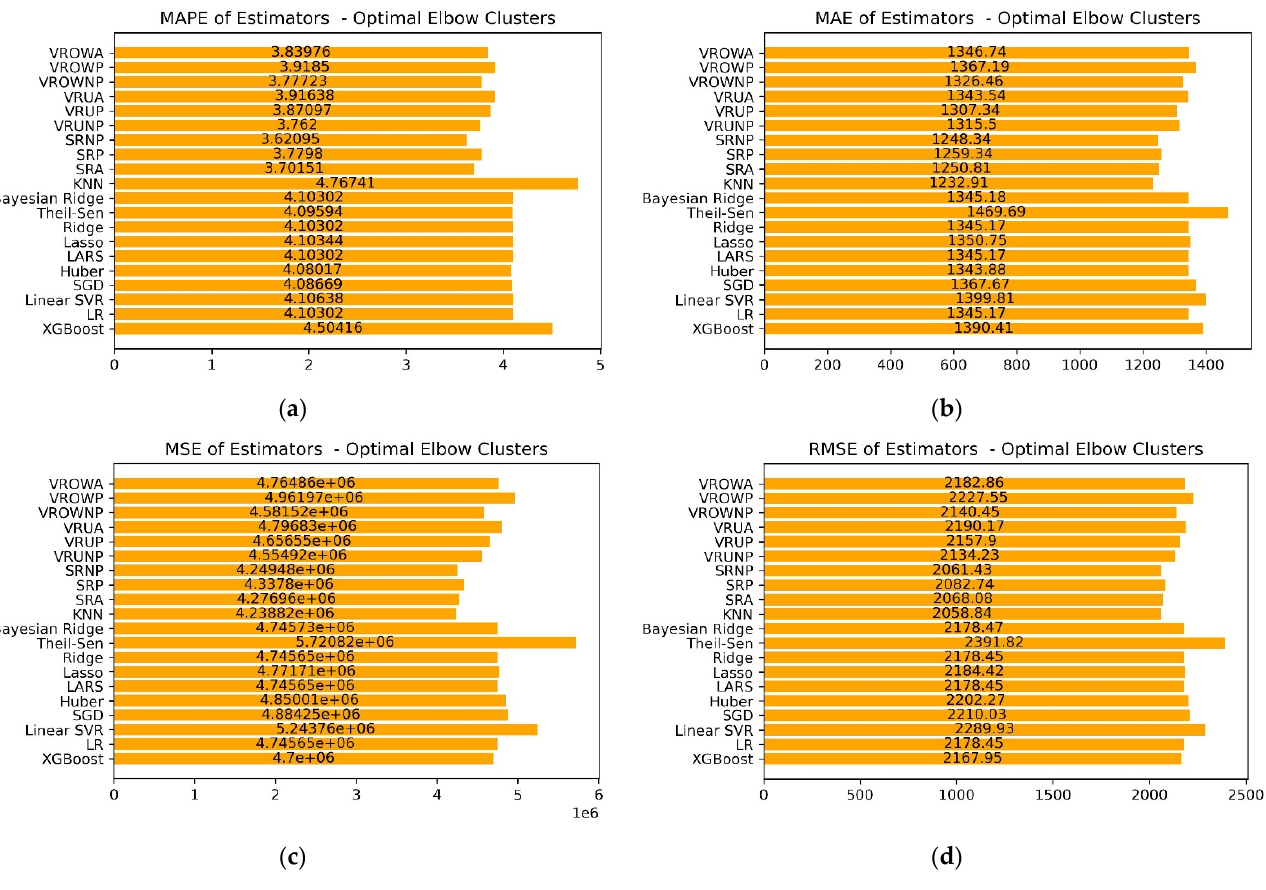
Figure 16. Error metric comparison for standalone estimators and structural ensemble models given the optimal clustering denoted by the elbow method. The panels present the following metrics: ( a ) Mean absolute percentage error; ( b ) Mean absolute error; ( c ) Mean squared error; ( d ) Root mean squared error.